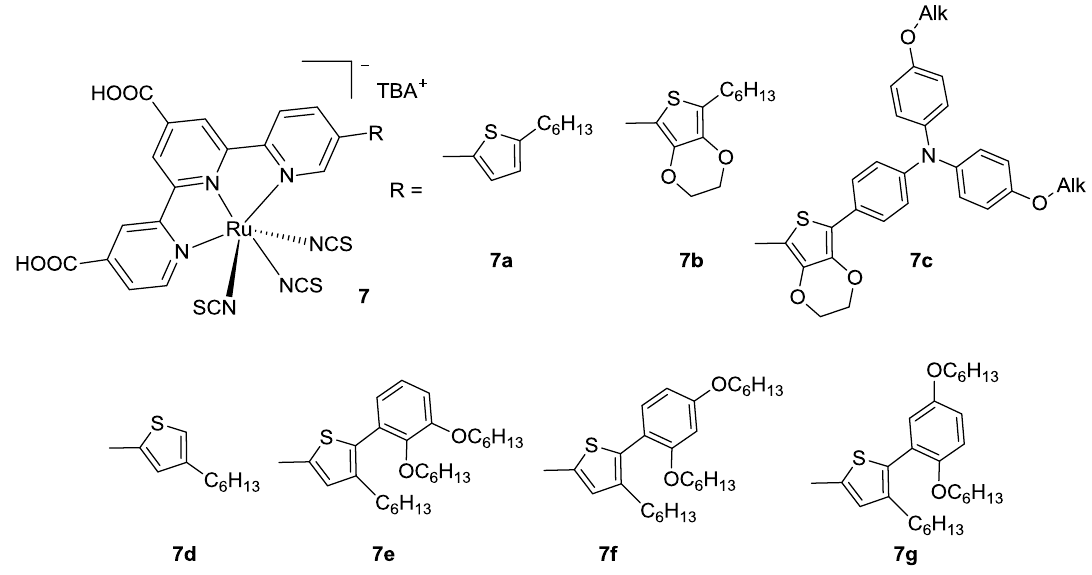
Figure 9. Series of 5’’-substituted tpy proposed by Yang ( 7a-c ) [78]; and Kimura ( 7d-g ) [79].